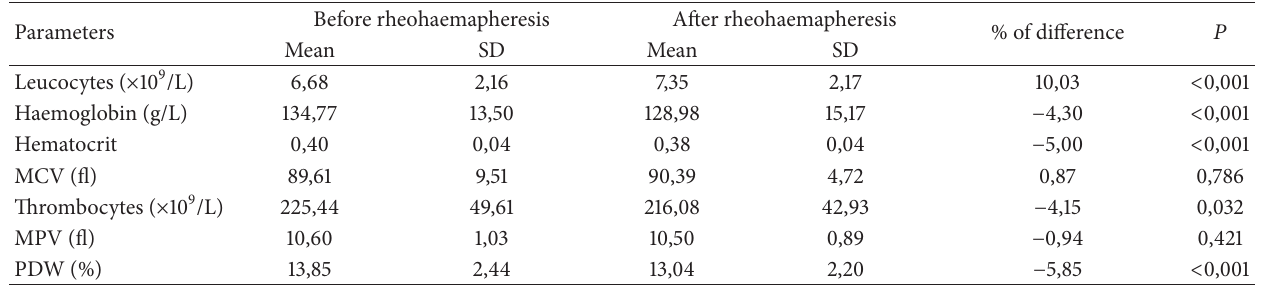
Table 3: Haematological parameters before and after rheohaemapheresis.